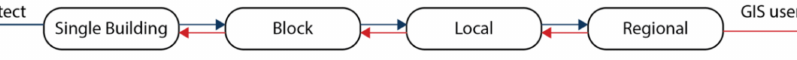
Figure 13. Serial flow chart of architects and GIS